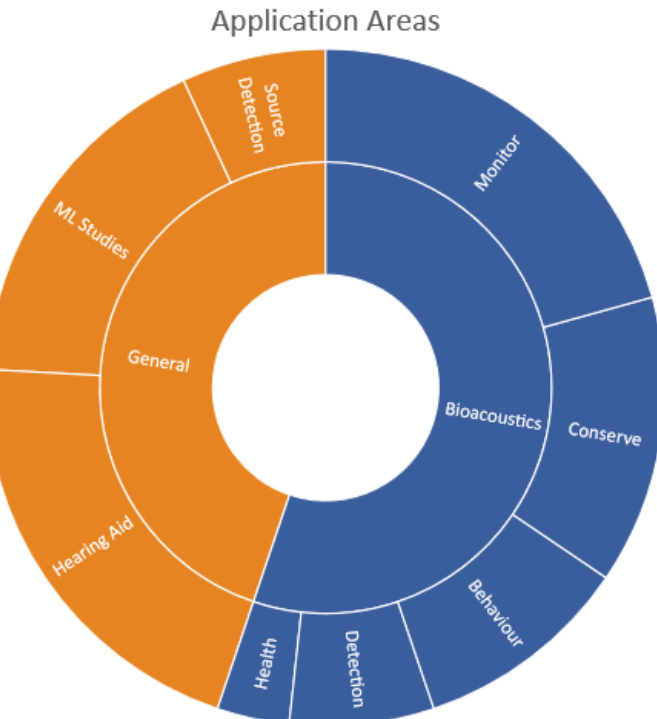
Figure 6. Application areas of research in bioacoustics and general acoustics